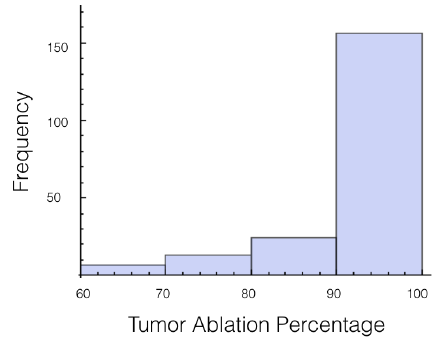
Figure 5. Histogram for percentage of tumor above 700 V/cm for case 2 at 1725 V.